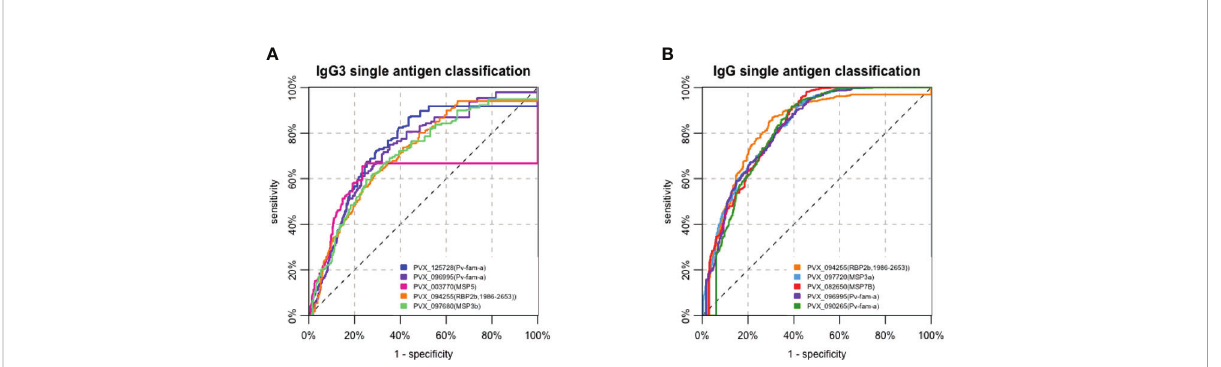
FIGURE 4 Receiver operating characteristic (ROC) curves of the top 5 (A) IgG3 and (B) total IgG responses to antigens in classifying recent Plasmodium vivax exposure (within 9 months) in a Peruvian cohort with moderate transmission intensity. The performance of each P. vivax antigen in the serological marker panel for classifying recent P. vivax infections in the prior 9 months was assessed individually using an ROC curve. (A) The top 5 antigen-speci fi c IgG3 responses that can classify P. vivax infection were against the following: two Pf-vam-a proteins (PVX_125728, PVX_096995), MSP5, RBP2b1986-2653, and MSP3b (AUC value = 0.714 – 0.764). (B) The top 5 antigen-speci fi c total IgG responses were against the following: RBP2b1986-2653, MSP3a, MSP7B, and two Pv-fam-a proteins (PVX_096995, PVX_090265) (AUC value = 0.818 –